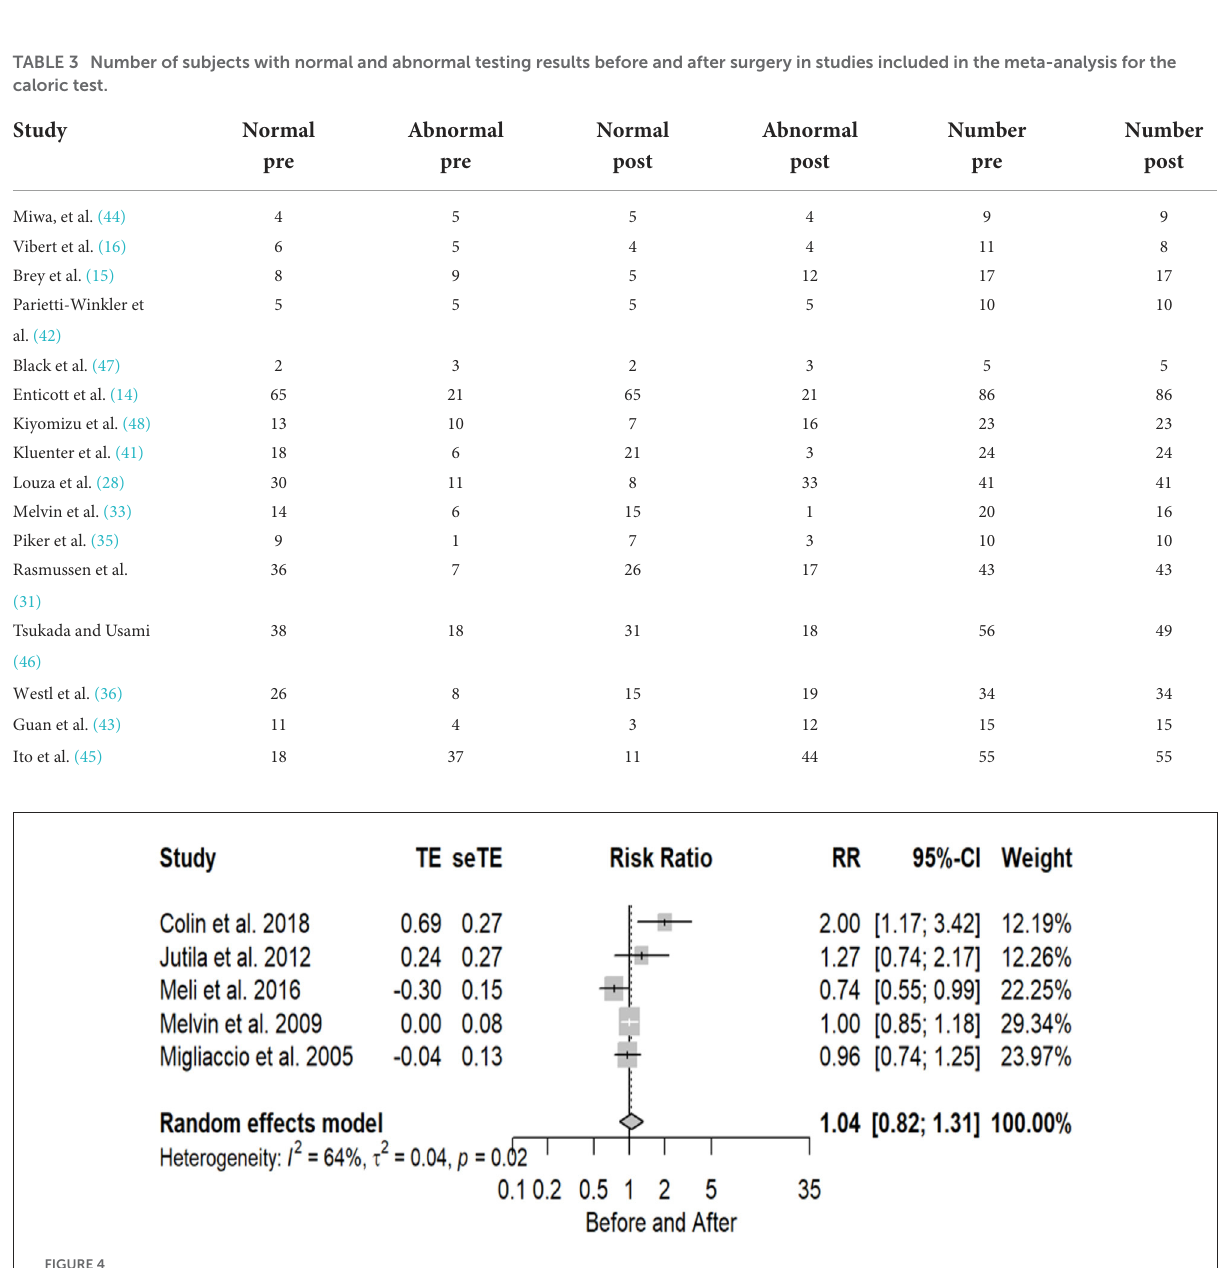
FIGURE4 Forest plot (showing relative effect sizes) for the HIT